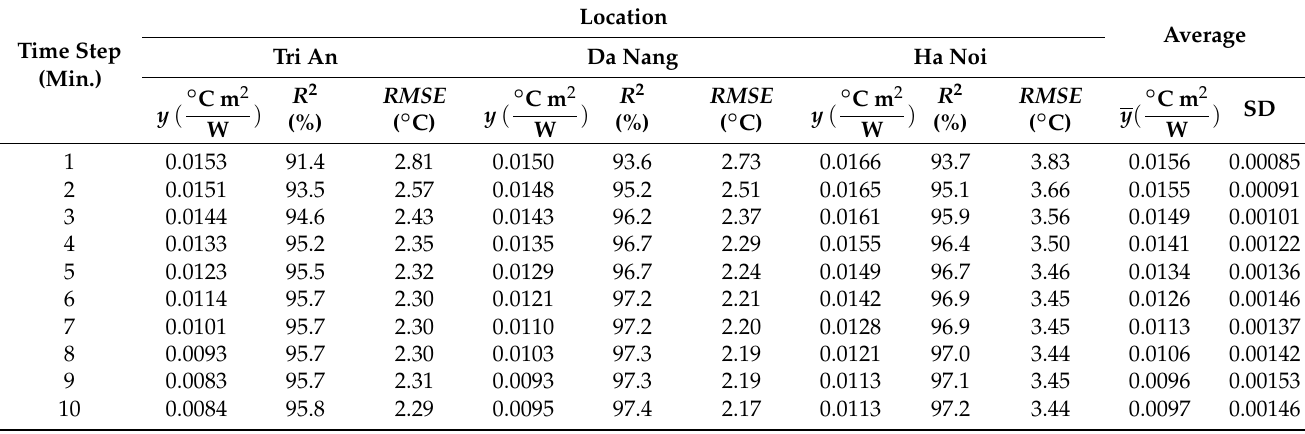
Table 4. Calculated values of y = temperature T m for three cities and for different values of the time step ∆ t .